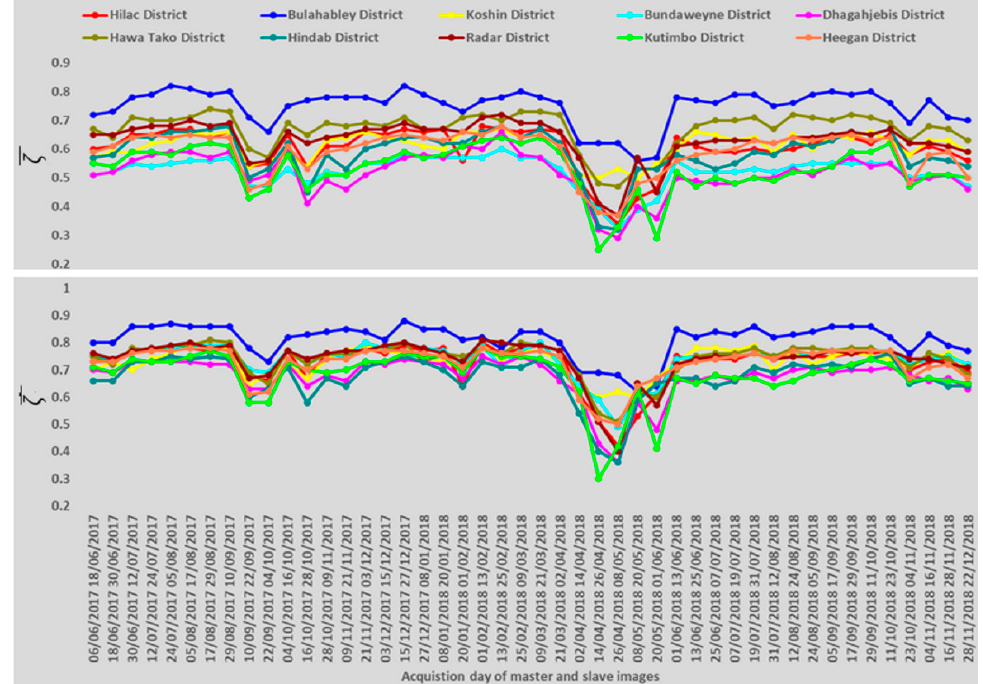
Figure 6. Same as Figure 5, but for the spatial average of the exponential of the interferometric phase.